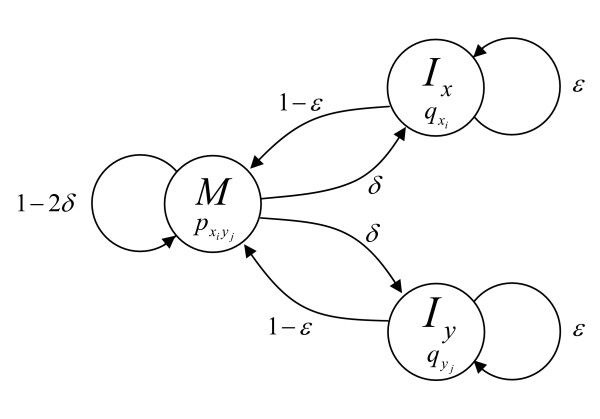
A pair-HMM for pairwise sequence alignment. A pair-HMM is used for alignment of loop regions and calculation of the posterior probabilities in score function. The state M has emission probability distribution pxiyj for emitting an aligned pair xi and yj. The state Ix has distributions qxi for emitting symbol xi against a gap. The state Iy has distributions qyj for emitting symbol yj against a gap. The parameters δ and ε are the state transition probabilities.